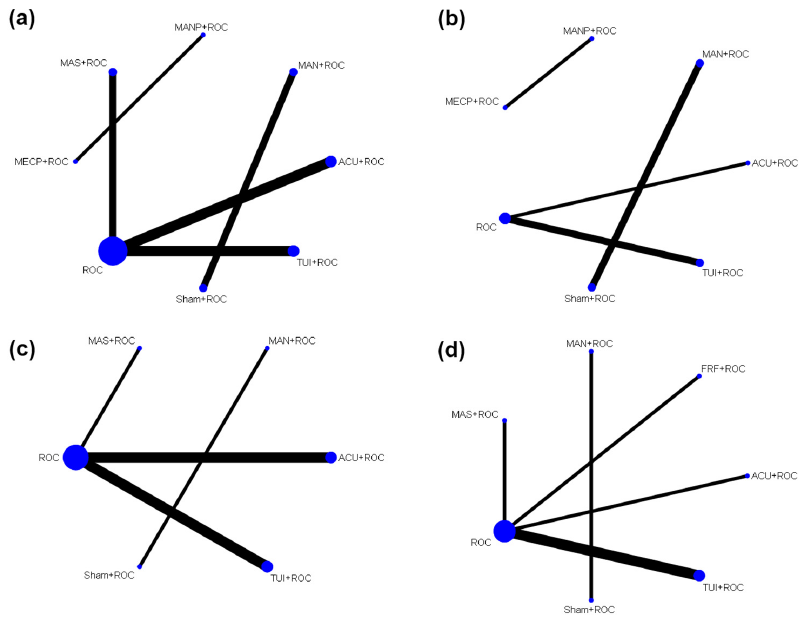
Figure 3. Network map of ( a ) FEV1 (L), ( b ) FVC (L), ( c ) FEV1/FVC (%), and ( d ) 6 min walking dis- tance. ACU—acupuncture; FRF—foot reflexology; MAN—manipulation; MANP—manual percus- sion; MAS—massage; MECP—mechanical percussion; ROC—routine care;